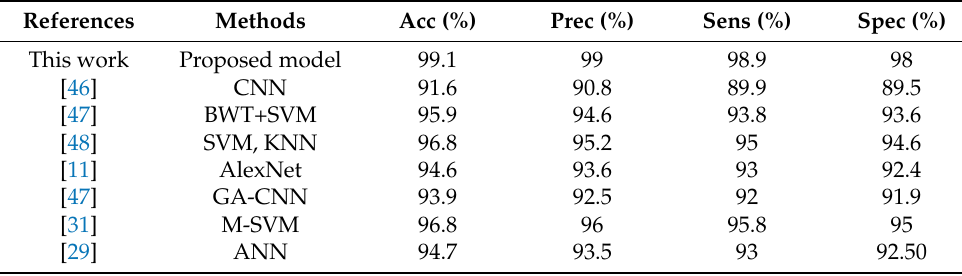
Table 3. Comparative study of the proposed model with recent state-of-art methods.